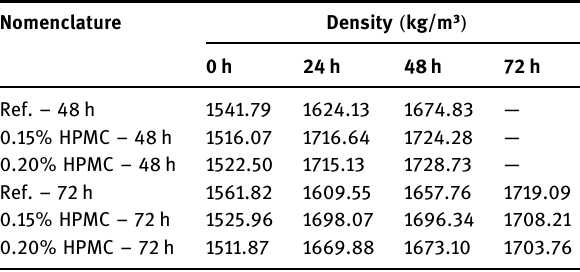
Table 9: Mass density over time for mortars with 48 and 72 h of